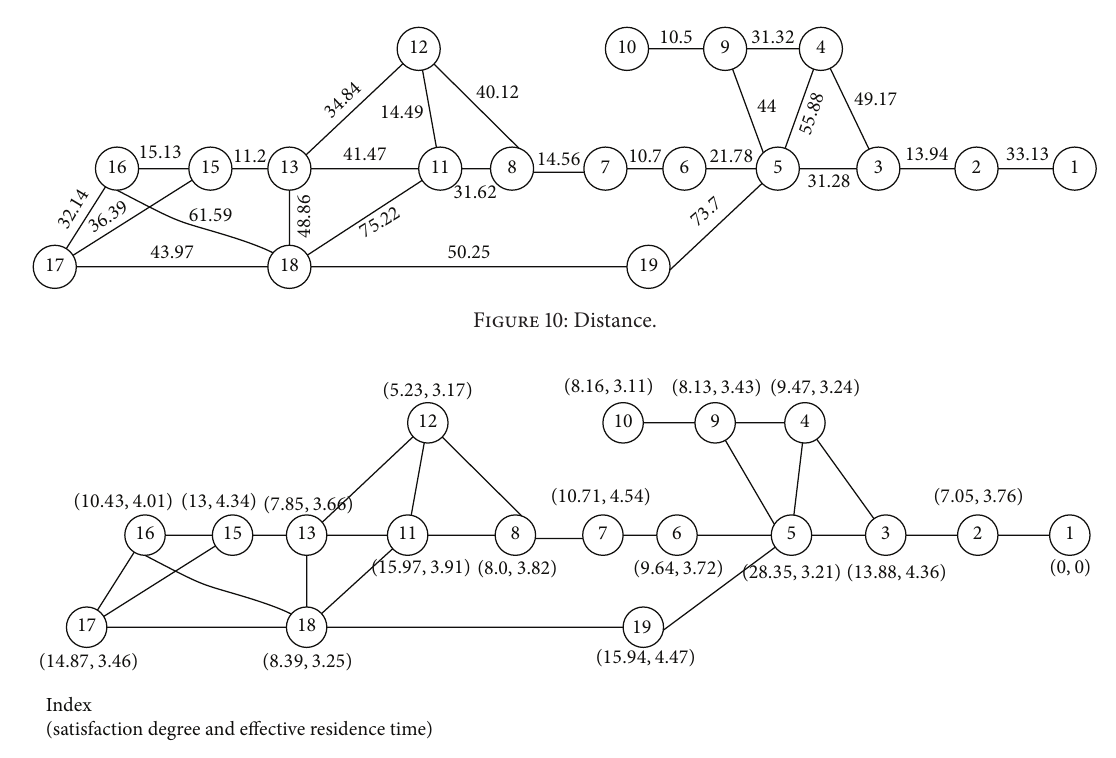
Figure 11: Effective residence time and satisfaction